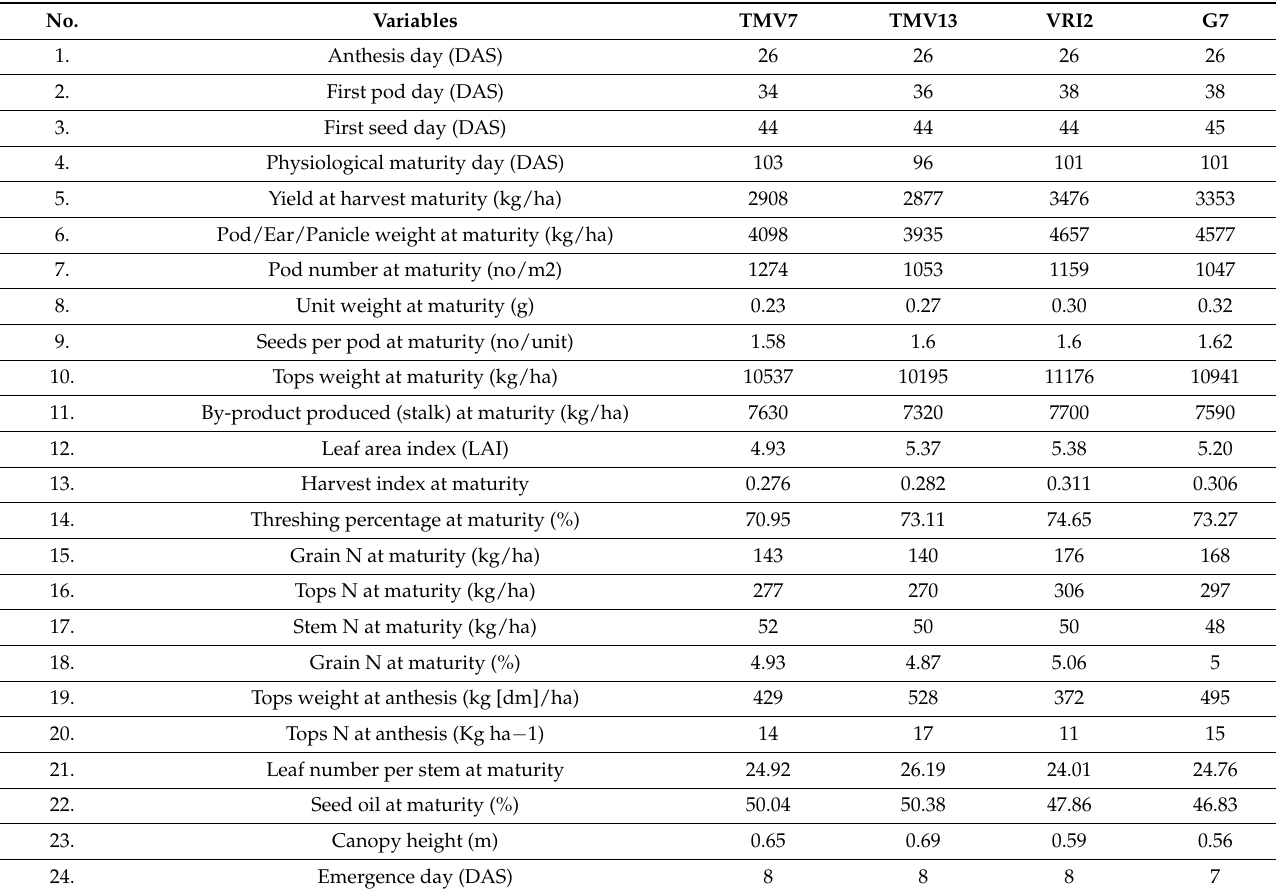
Table 4. Growth and development variables simulated by DSSAT CROPGRO Peanut on predominant varieties cultivated in the study